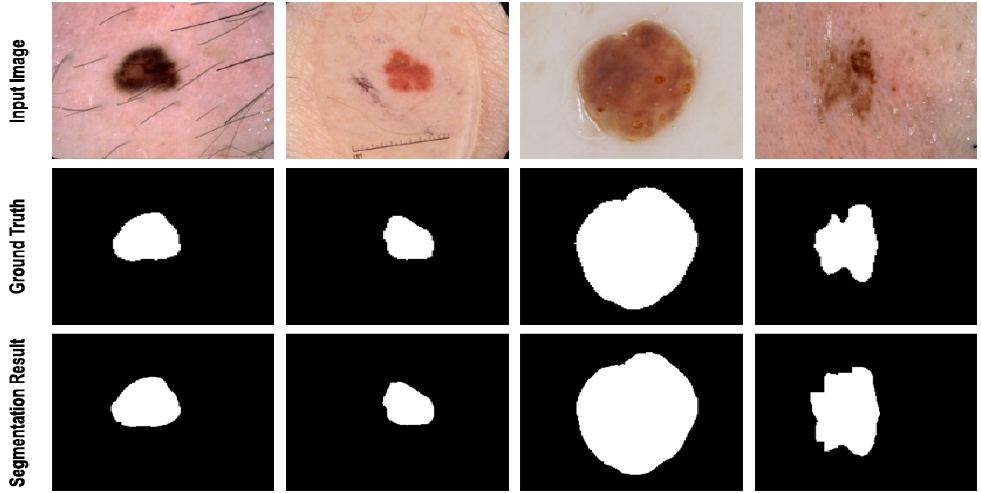
Figure 3. Segmentation results of the proposed method on ISIC 2017. The proposed method pro- duces a smooth segmentation result on the boundary area and separates the lesion area from the overlapped background.